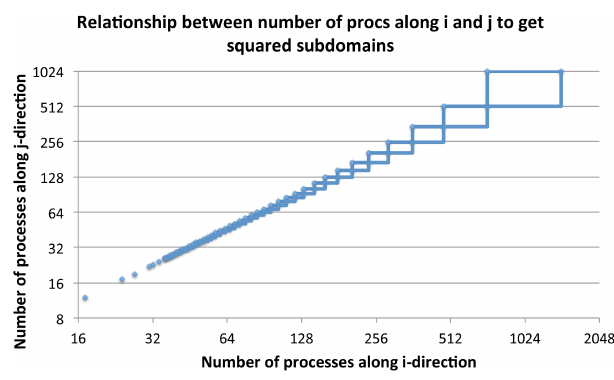
Figure 8. Relationship between the number of processes along the i and j directions to get exactly squared subdomains. If the number of processes falls within the blue boxes, the resulting decomposition is a perfect square.